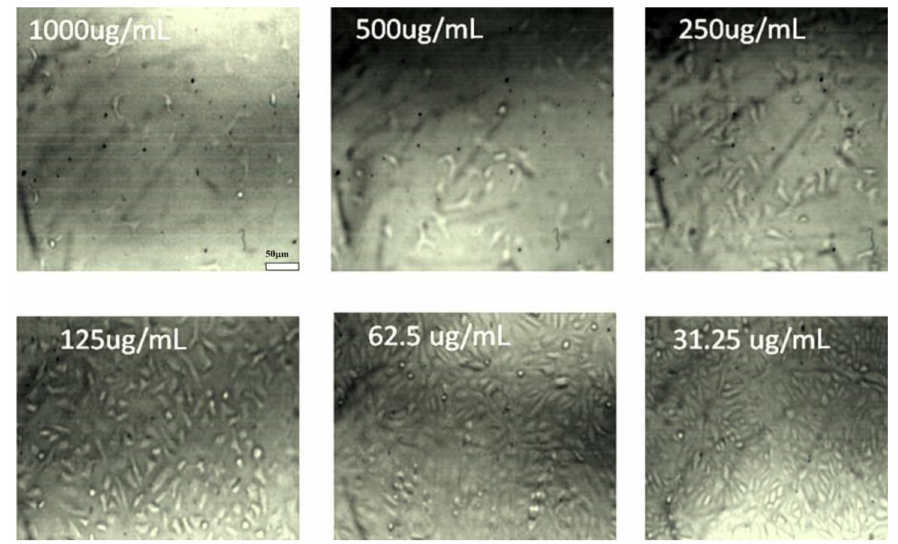
Figure 14. The impact of palladium nanoparticles at various doses on MCF-7